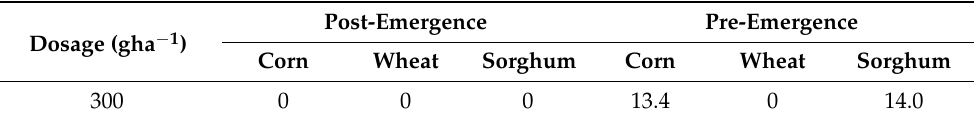
Table 5. Herbicidal activities of compound V-8 .